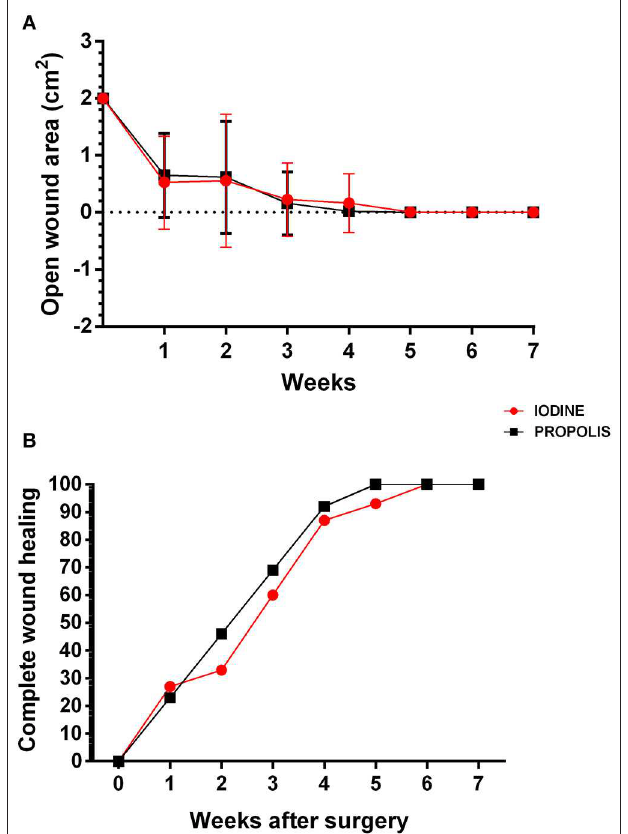
FIGURE 1 | Wound healing process in animals treated with iodine or green propolis-based ointment. (A) Open wound area 2 weeks after surgery. Averages of the open wound area in each experimental group over the weeks are presented, and bars represent their standard deviations. The results of the two groups at each time were compared by Student’s t -test with p < 0.05; no significant differences were found. (B) Percentage of animals from each experimental group with complete wound healing. The points on the chart show the percentage of animals in each group achieving complete healing over the weeks.